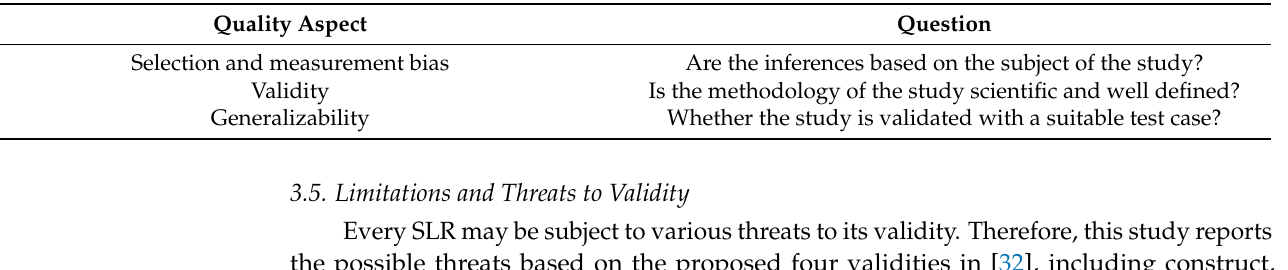
Table 2. Study quality assessment